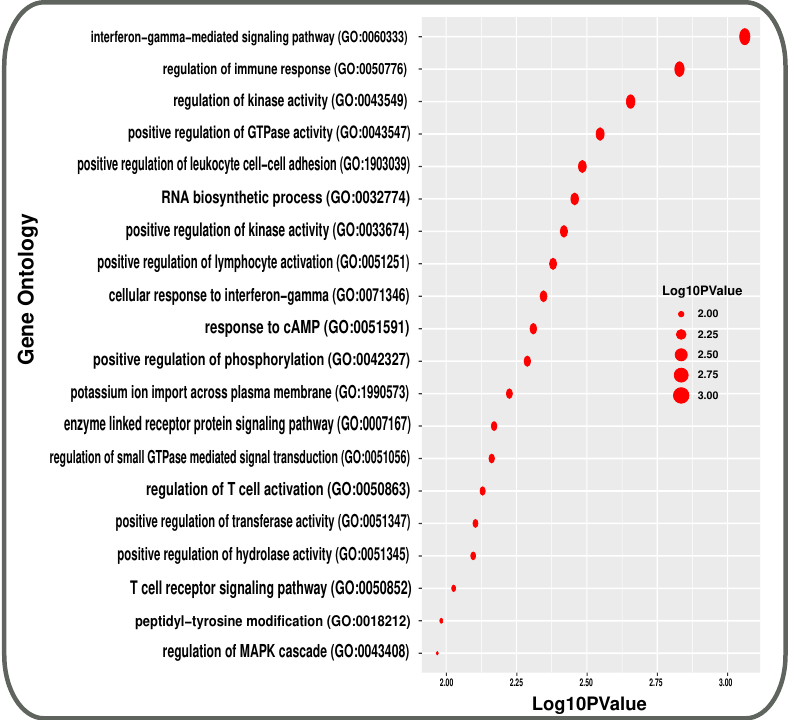
Figure 5. Top 20 Gene Ontologies represented using a bubble plot that are linked with both conditions in transcriptomic